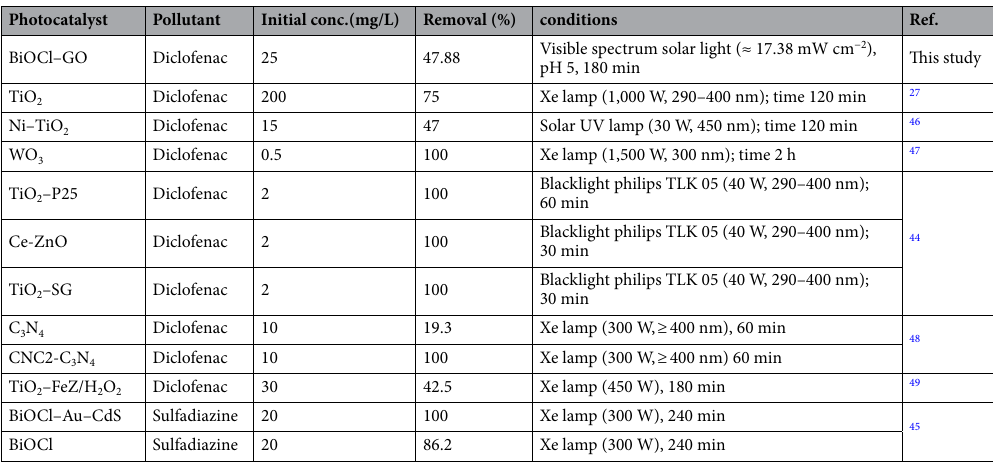
Table 3. Comparison with literature studies for photocatalytic degradation of diclofenac.